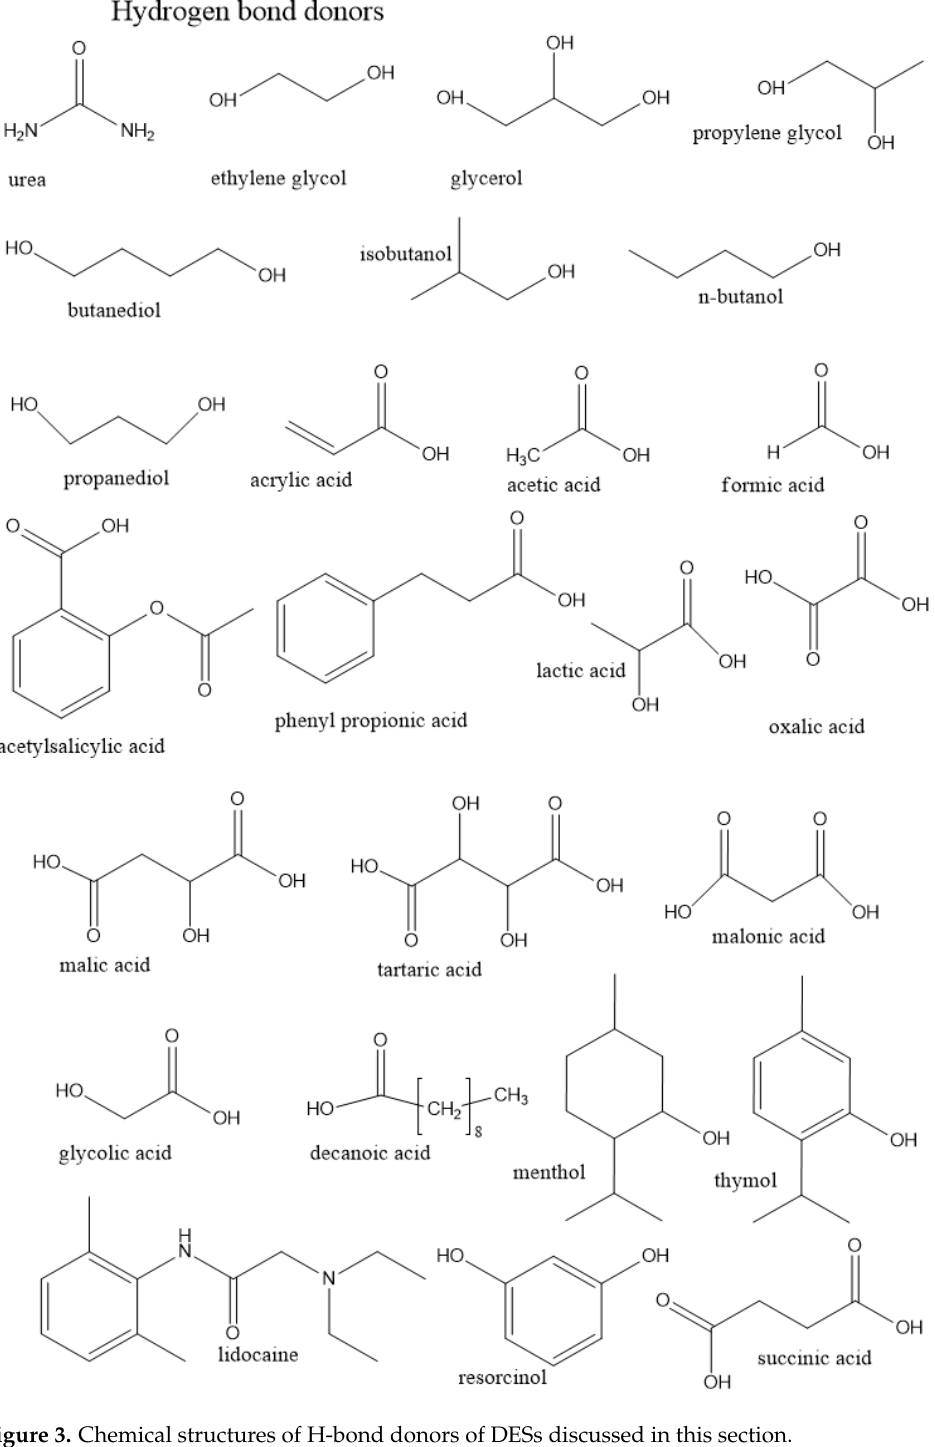
Figure 3. Chemical structures of H-bond donors of DESs discussed in this section.